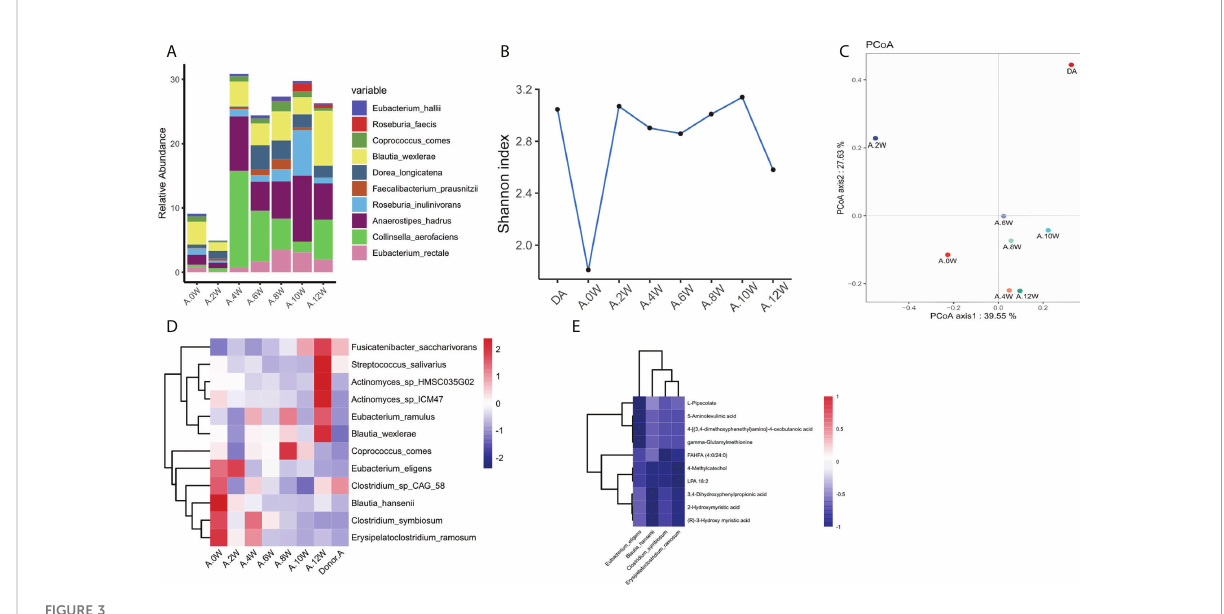
FIGURE 3 Characteristics of gastrointestinal microbiota in patient case 1. (A) . Composition of the top 10 species at the species level. (B) . The diversity (Shannon index) of gastrointestinal microbiota. (C) . Principal coordinate analysis (PCoA) was used to investigate the similarity of microbial communities at different time points. (D) . Strains with the same change trend before and after treatment with three treatments. (E) . Correlation between strains with the same change trend and metabolites in neg mode. *p <